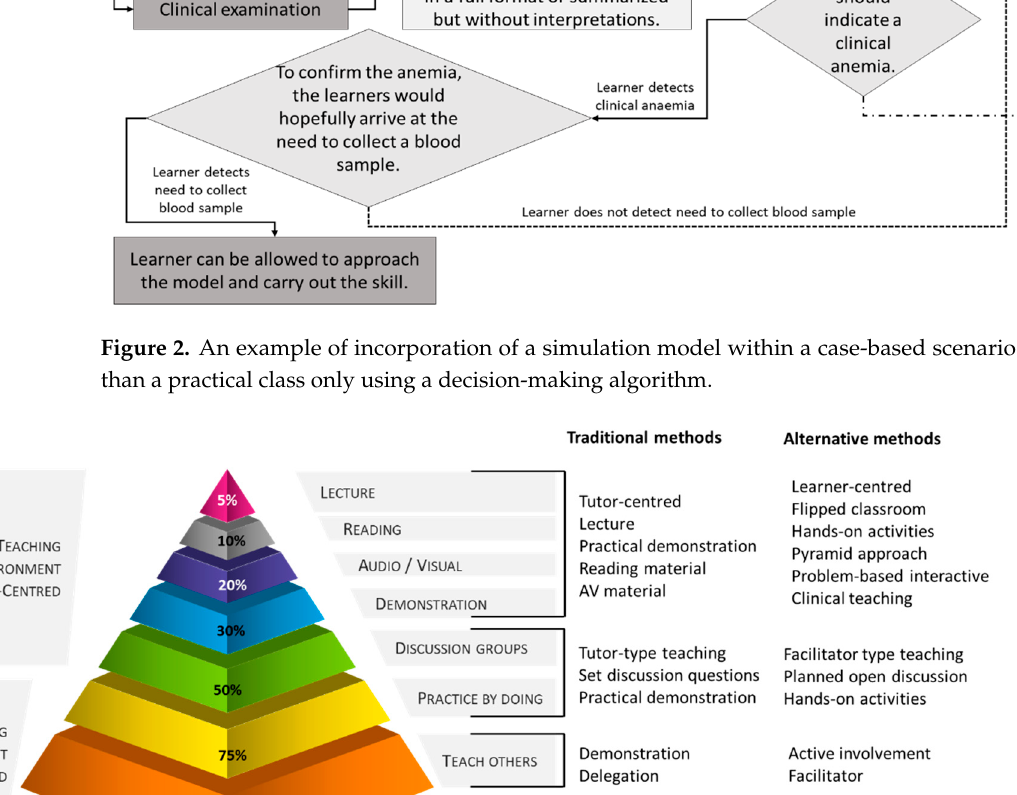
Figure 3. The effect of teaching method on the retention of knowledge by learners demonstrating the need of a component of ‘teach others’ by learners in the clinical teaching. Adapted from [56]. AV—Audio-visual.